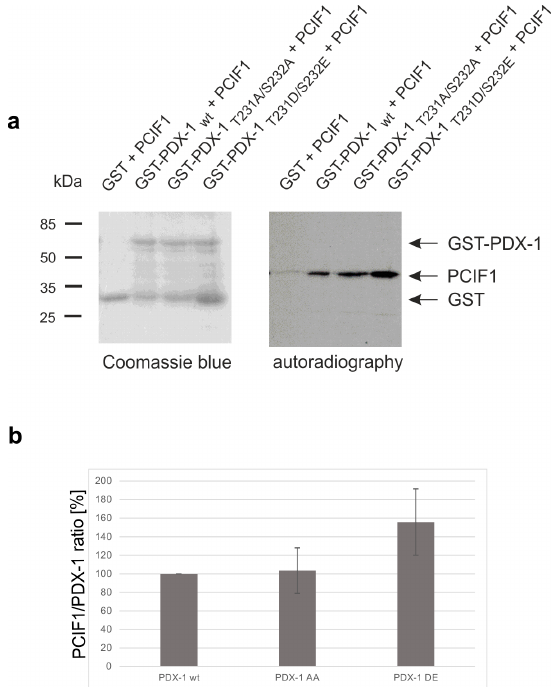
Figure 3. Interaction of PDX-1 and PCIF1 as a function of CK2 phosphorylation. ( a ) GST pull-down analysis of the PCIF1/PDX-1 interaction. About 10 µ g GST-PDX-1 WT , GST-PDX-1 T231A/S232A , or GST-PDX-1 T231D/S232E were incubated with 7.5 µ L of in vitro translated and [ 35 S]-methionine labeled PCIF1 protein. The formed complex was coupled to GSH sepharose. Proteins eluted from the affinity resins were analyzed on a 12.5% SDS polyacrylamide gel, stained with Coomassie blue and afterwards subjected to autoradiography; and ( b ) after densitometric analysis of the PDX-1 and PCIF1 signals the PCIF1/PDX-1 ratio was calculated and the relative values were presented as bar graphs referred to the interaction of wild-type PDX-1 and